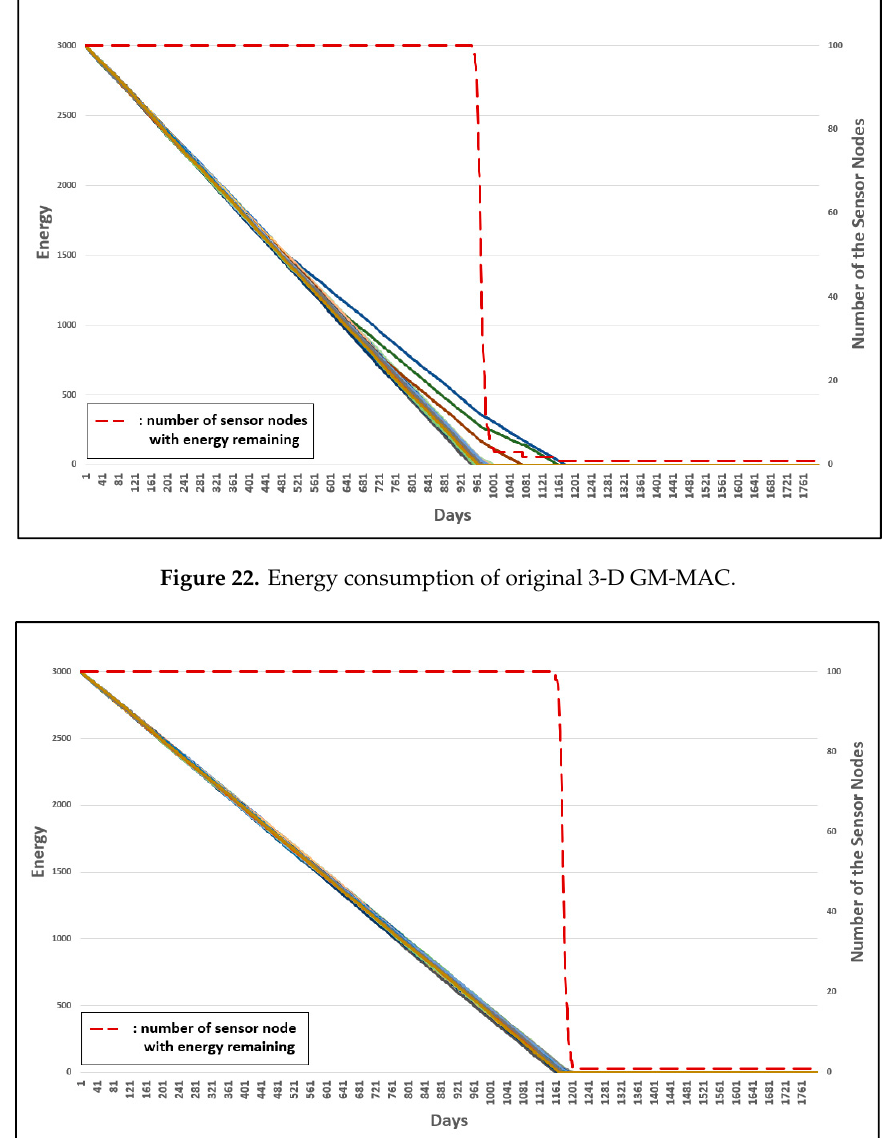
Figure 23. Energy consumption of 3-D GM-MAC using advanced group number management.